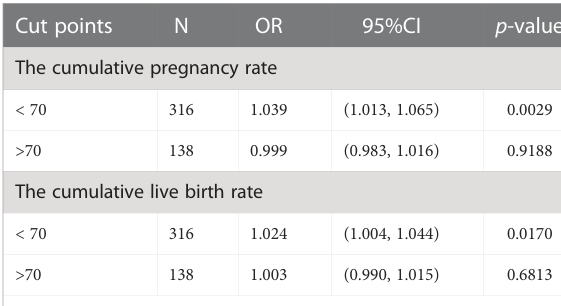
TABLE 5 The threshold effect analysis of the follicular output rate and clinical